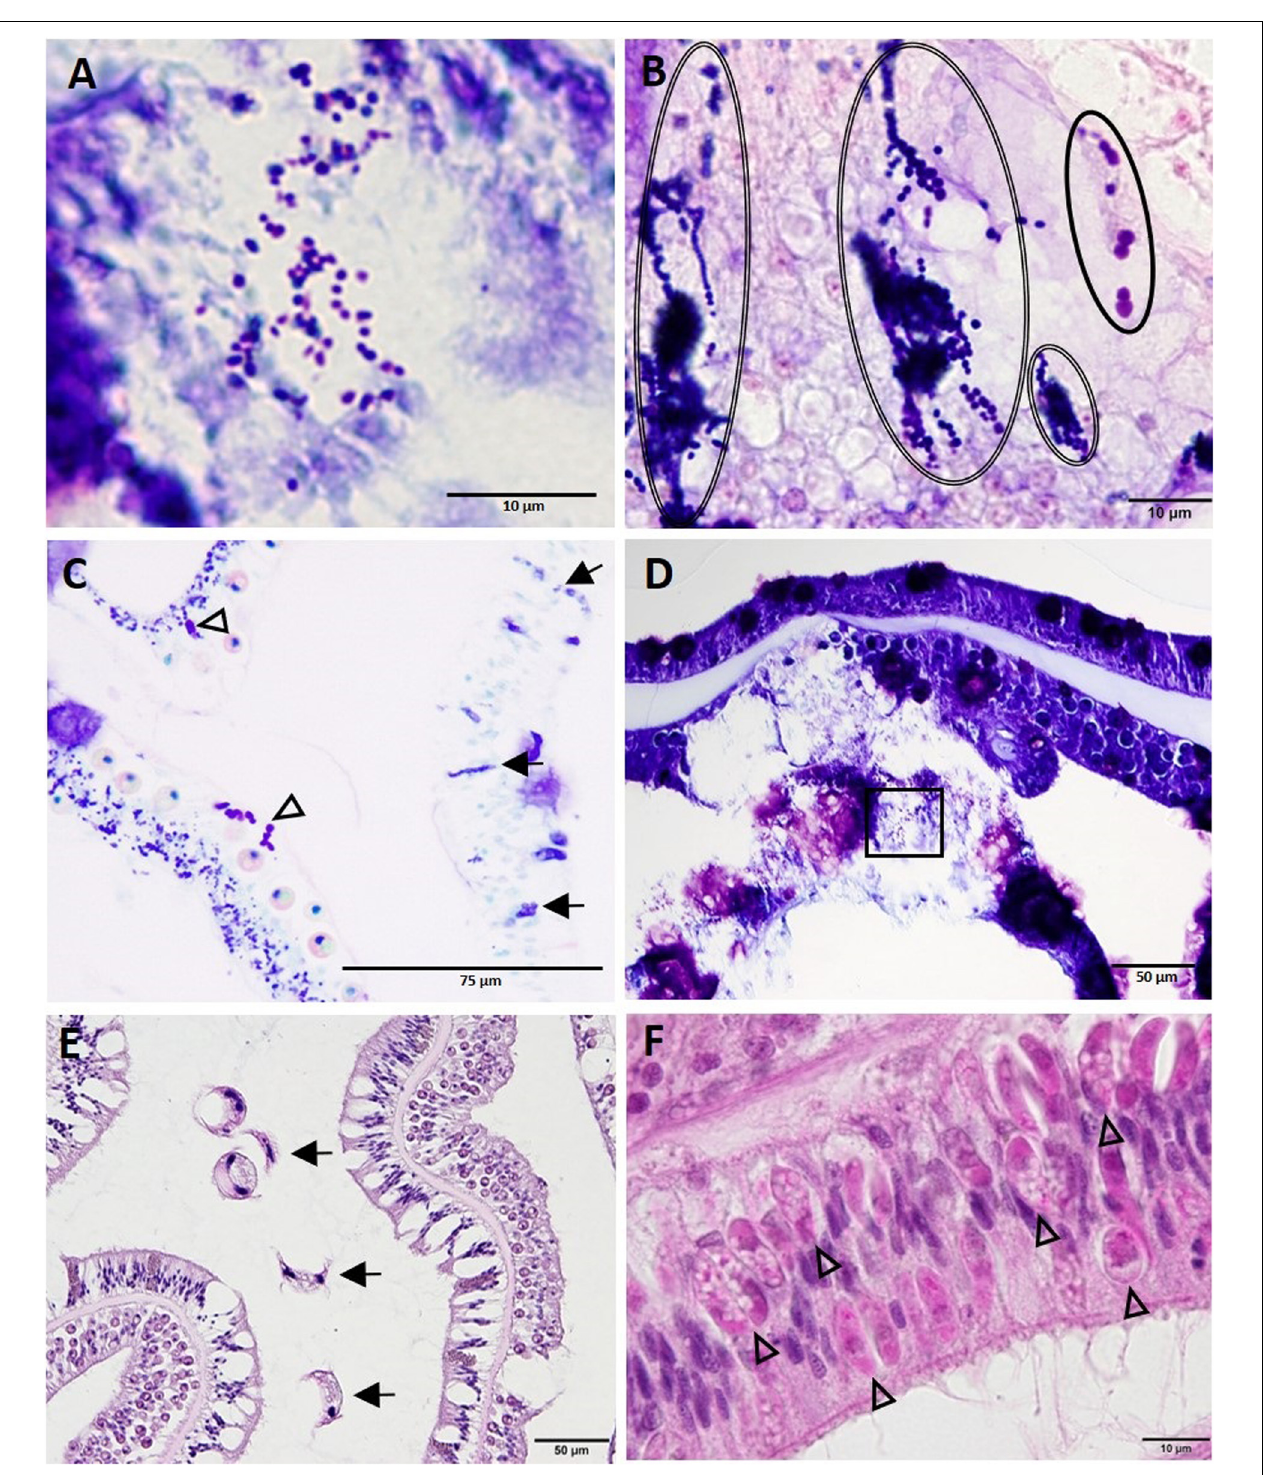
FIGURE 13 | Diverse coccoidlike structures and parasites. (A) High magnification of inset area marked in (D) shows coccoidlike structures in necrotic basal body wall (BBW) gastrodermis associated with lytic necrosis (LN) lesion in Montastraea cavernosa . (B) Coccoidlike structures (double-line ovals) and coccobacilloidlike structures (solid oval) in mesentery of apparently healthy tissue of Diploria labyrinthiformis. (C) Coccoidlike structures (arrows) in the epidermis and coccobacilloidlike structures (arrowheads) in the SBW gastrodermis of an apparently healthy area in M. cavernosa . (D) LN in BBW and SBW gastrodermis in M. cavernosa showing location of coccoidlike structures [inset shown in (A) ]. (E) Surface of Pseudodiploria strigosa showing trichodinid ciliates (arrows). (F) Apicomplexan sporozoites (arrowheads) in the actinopharynx epidermis of M. cavernosa . (A,D) thionin; (B,C) Giemsa; (E,F) hematoxylin and eosin (H and E).